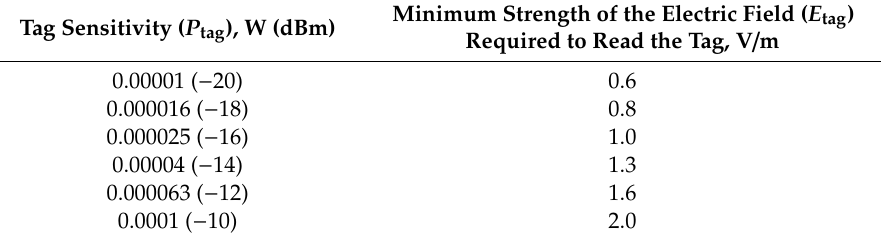
Table 3. Minimum strength of the electric field ( E tag ) required to read the UHF RFID tags of di ff ering sensitivities ( P tag ), operating at a frequency of 865